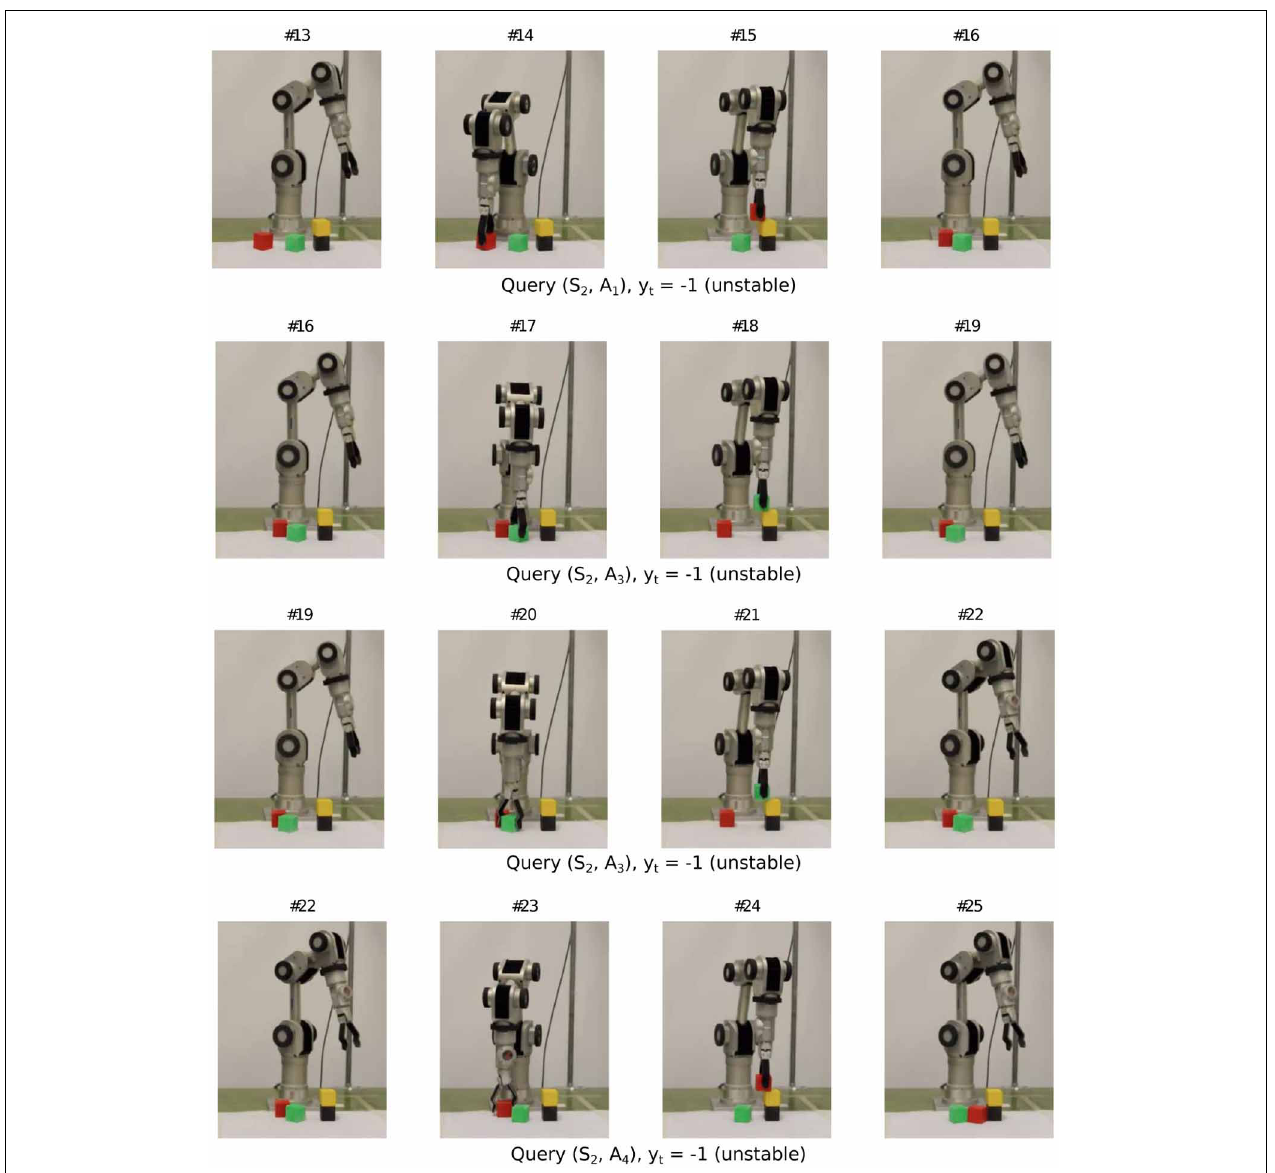
FIGURE 11 | Sample query sequence on real robot